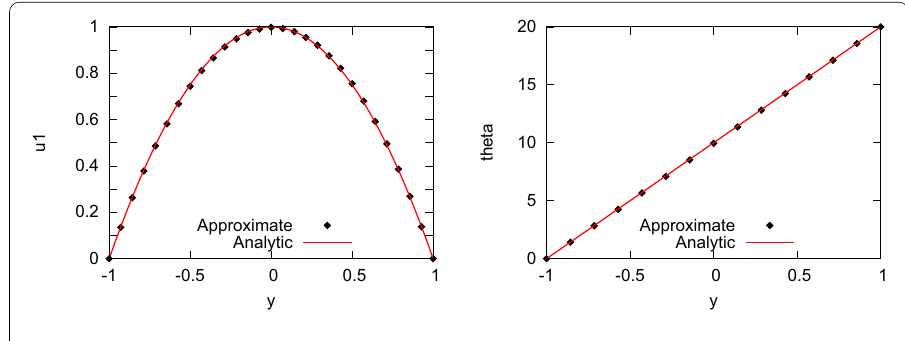
Fig. 30 Velocity (left) and θ (right) profile at x = 3 L / 4